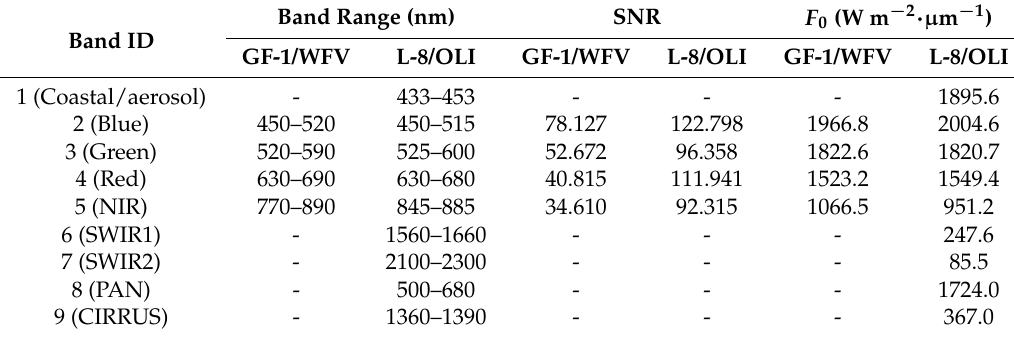
Table 1. Comparison of band range, signal-to-noise ratio (SNR) [15] and extraterrestrial solar irradiance ( F 0 ) between Landsat-8/OLI and